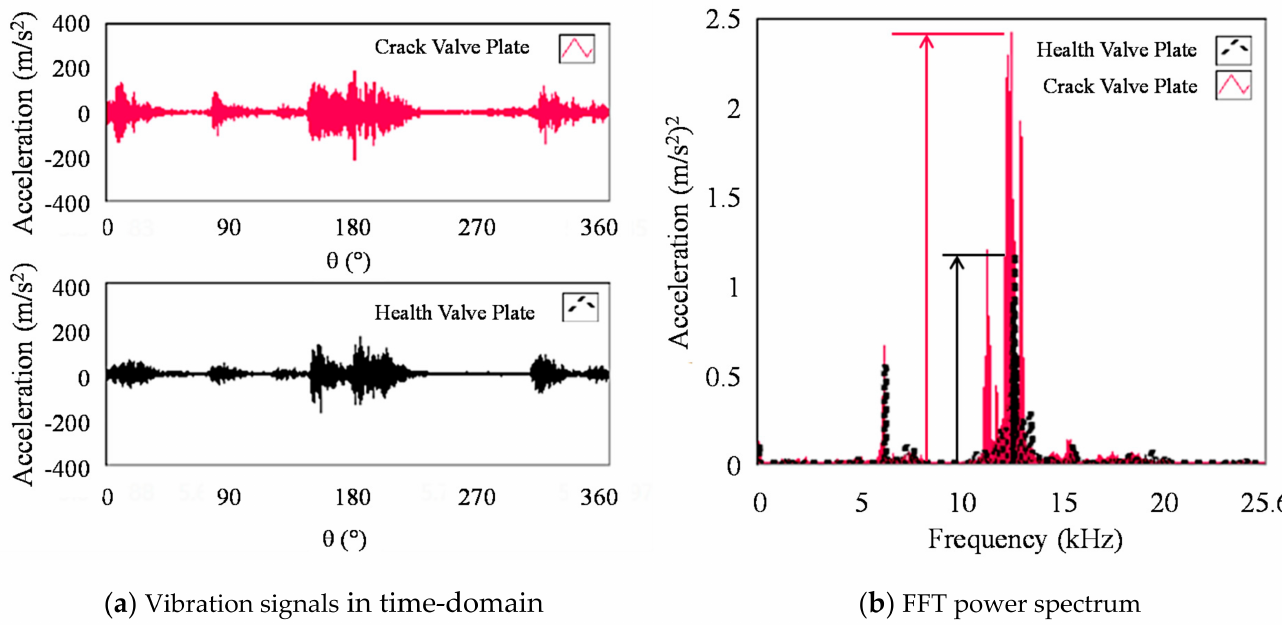
Figure 18. Vibration signals of crack valve plate and health valve plate acquired from valve